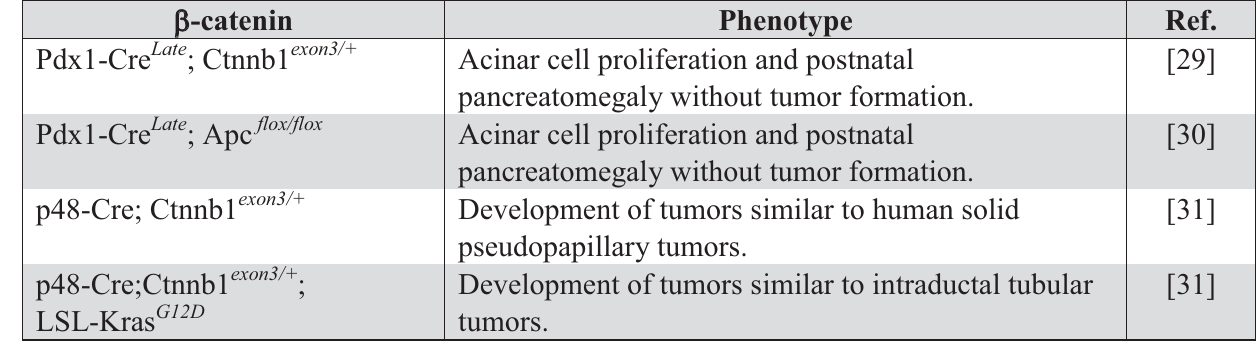
Table 1. (cid:2) -catenin Associated Genetic Mouse Models of Pancreas Cancer. (cid:2)(cid:2) -catenin Phenotype